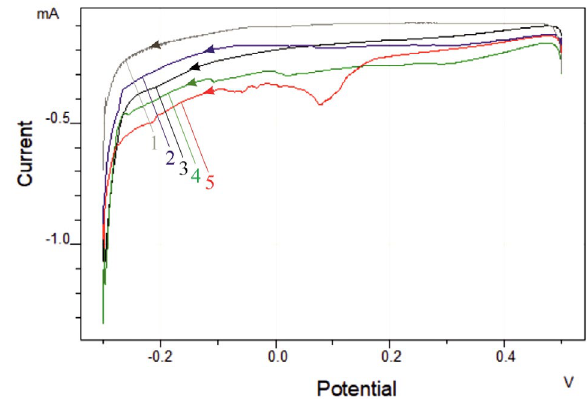
Fig . 4 . The effect of concentaration of the molybdate ions to elect- roreduction process on the Pt electrode. The electrolyte consists of 0.007 C 4 H 6 O 6 + (M) Na 2 MoO 4 2H 2 O. M= 1- 0.1; 2- 0.2; 3- 0.3; 4- 0.4; 5- 0.5, at Т = 293 К, and Е V = 0.02 V/s.